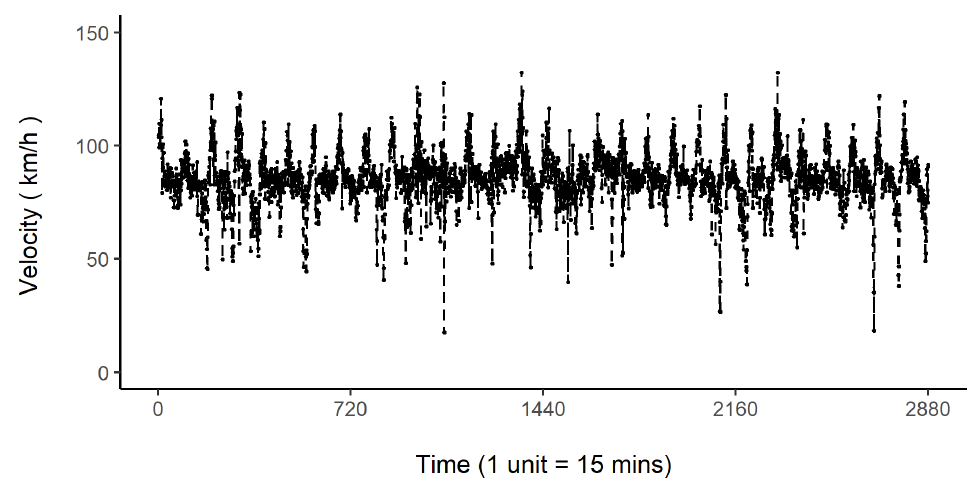
Figure 3. Traffic speed for one month between Singal junction and Seoul toll gate.